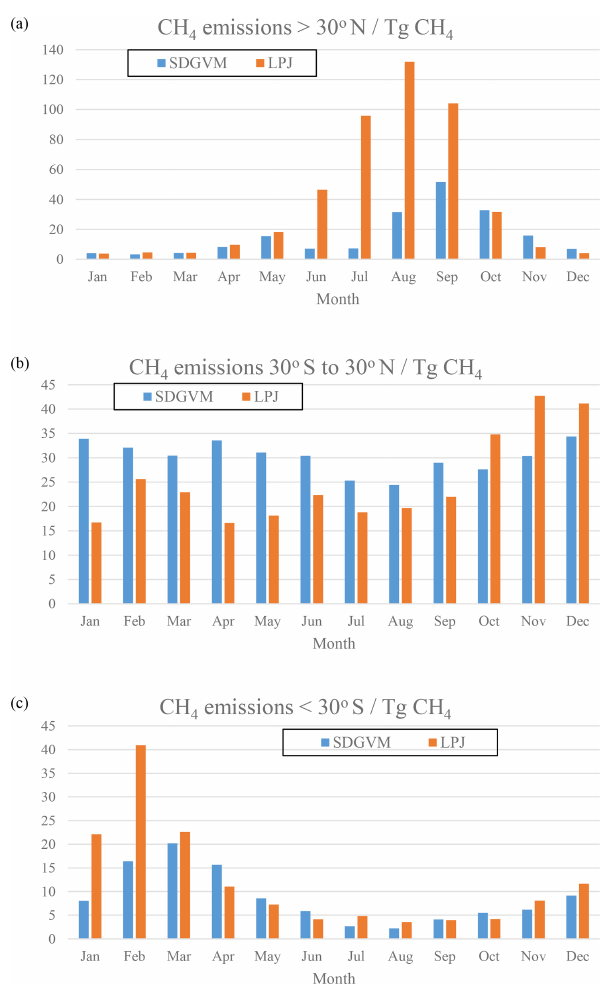
Figure 9. Monthly variations in wetland CH 4 emissions (TgCH 4 ) calculated from predicted FW for the Eocene climate by SDGVM and LPJ, for (a) all areas north of 30 ◦ N, (b) all areas between 30 ◦ S and 30 ◦ N and (c) all areas south of 30 ◦